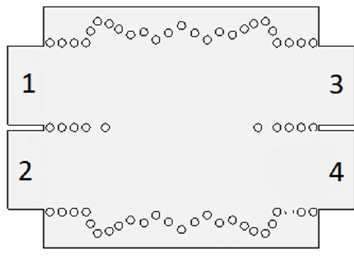
Figure 1. Substrate integrated waveguide 3 dB coupler.